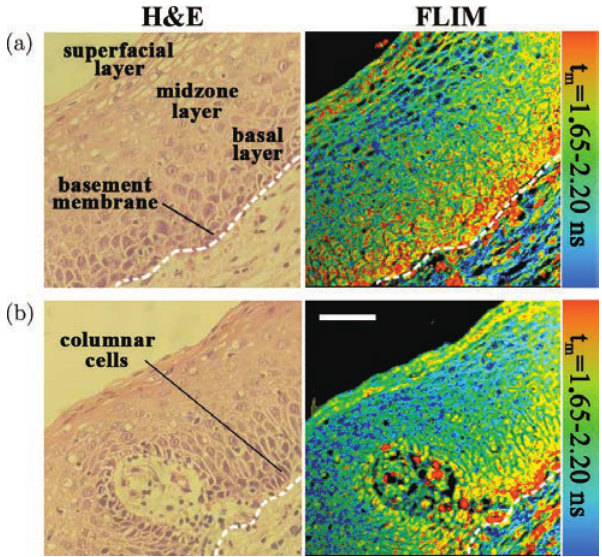
Fig. 2. H & E images and FLIM images of (a) a typical epi- thelium structure of normal cervix, (b) an epithelium of cervix with a capillary. The FLIM measurements were done by the single-channel TCSPC system on an unstained slide from Patient No. 8. After FLIM imaging, the slide was stained for H & E imaging. The white dash line indicates the boundary of the basement membrane. Scale bar: 50 (cid:1)